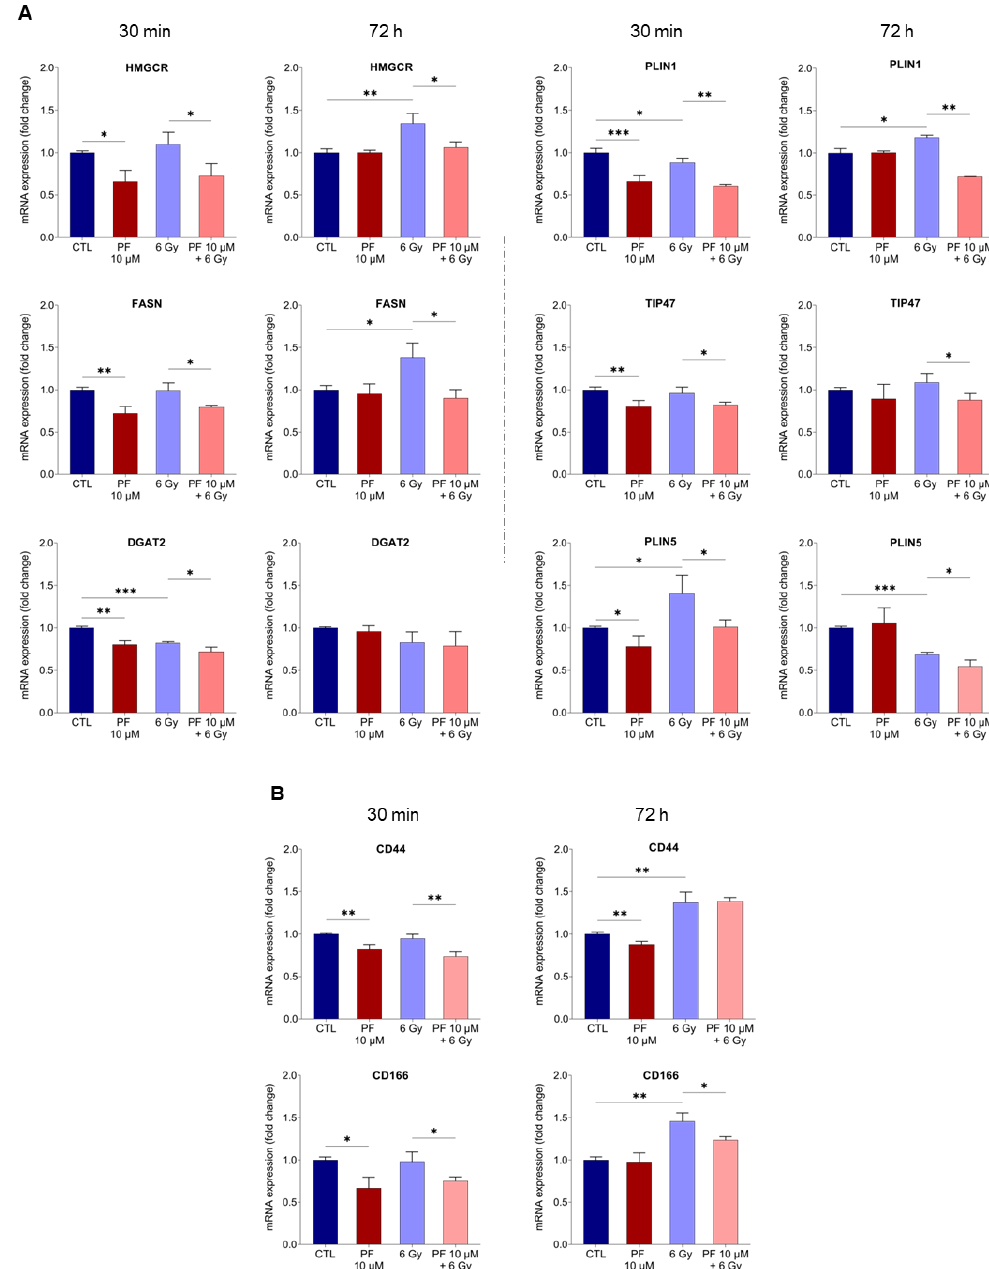
Figure 3. MCF7 pre-treatment with 10 µM PF-06424439 followed by radiation modulates lipid gene metabolism and CSC-related gene expression. ( A ) RT-qPCR results showing the relative mRNA expression of HMGCR, FASN, and DGAT2 as well as LD-associated genes, PLIN1, TIP47, PLIN5 after 30 min and 72 h from irradiation (6 Gy) in MCF7 cells untreated and pre-treated with 10 µM PF-06424439. ( B ) The relative mRNA expression of CSC markers, CD44, and CD166, evaluated by RT q-PCR at 30 min and 72 h after irradiation. Data are represented as means ± SD from three different experiments performed in triplicate (* p ≤ 0.05; ** p ≤ 0.01; *** p ≤ 0.001). RT q-PCR analysis, after 72 h from irradiation, revealed that X-rays increased the gene expression of HMGCR, FASN, PLIN1 and reduced the gene expression of PLIN5,